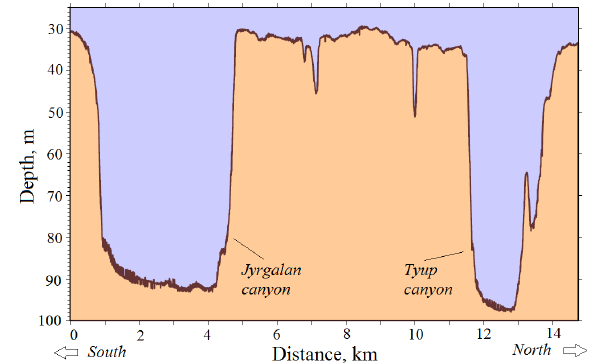
Figure 14. Bathymetric profile of a meridional section across the Jyrgalan and Tyup canyons at 77.9 ◦ E obtained by echo soundings on 25 June